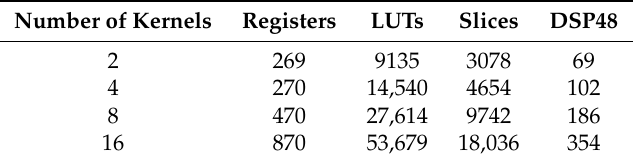
Table 1. Resource utilization of the XOR gate dataset—floating point.